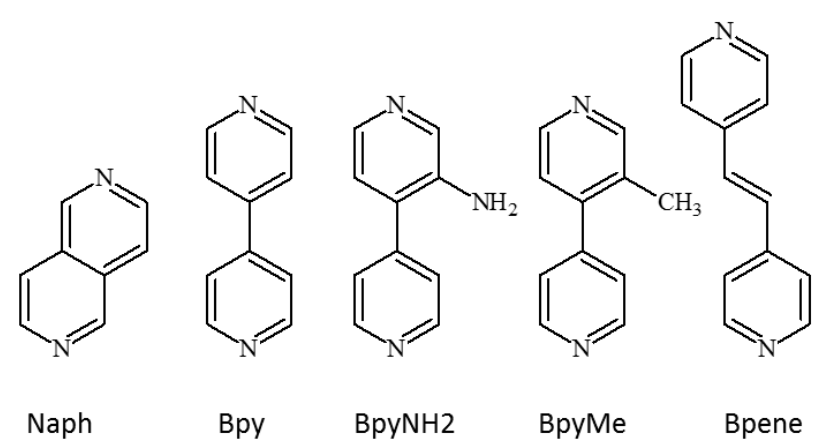
Figure 5. Schematic drawing of the chemical formulas for the five pillar ligands: Naph, C 8 N 2 H 6 ; Bpy, C 10 N 2 H 8 ; BpyNH2, C 10 N 3 H 9 ; BpyMe, C 11 N 2 H 10 ; and Bpene, C 12 N 2 H 10